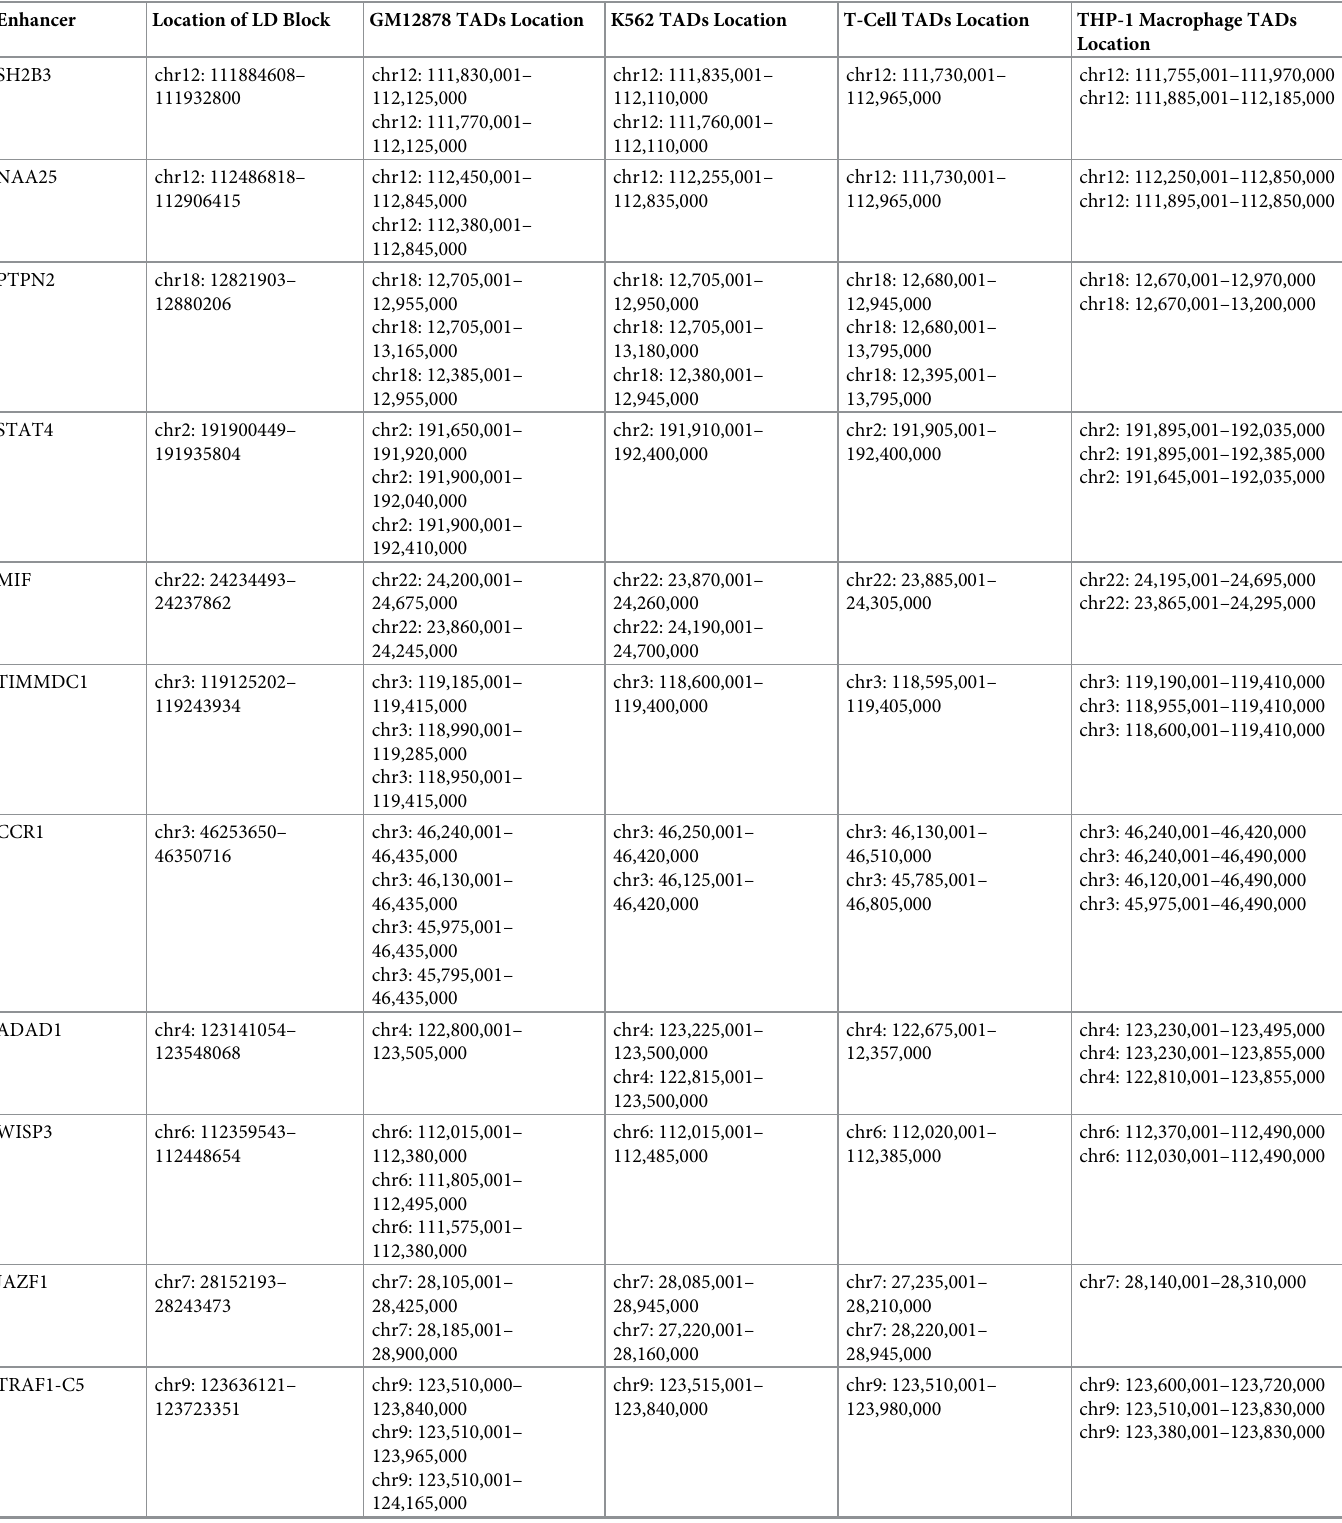
Table 2. Identification of TADs incorporating JIA risk haplotypes within human leukocyte cell lines.